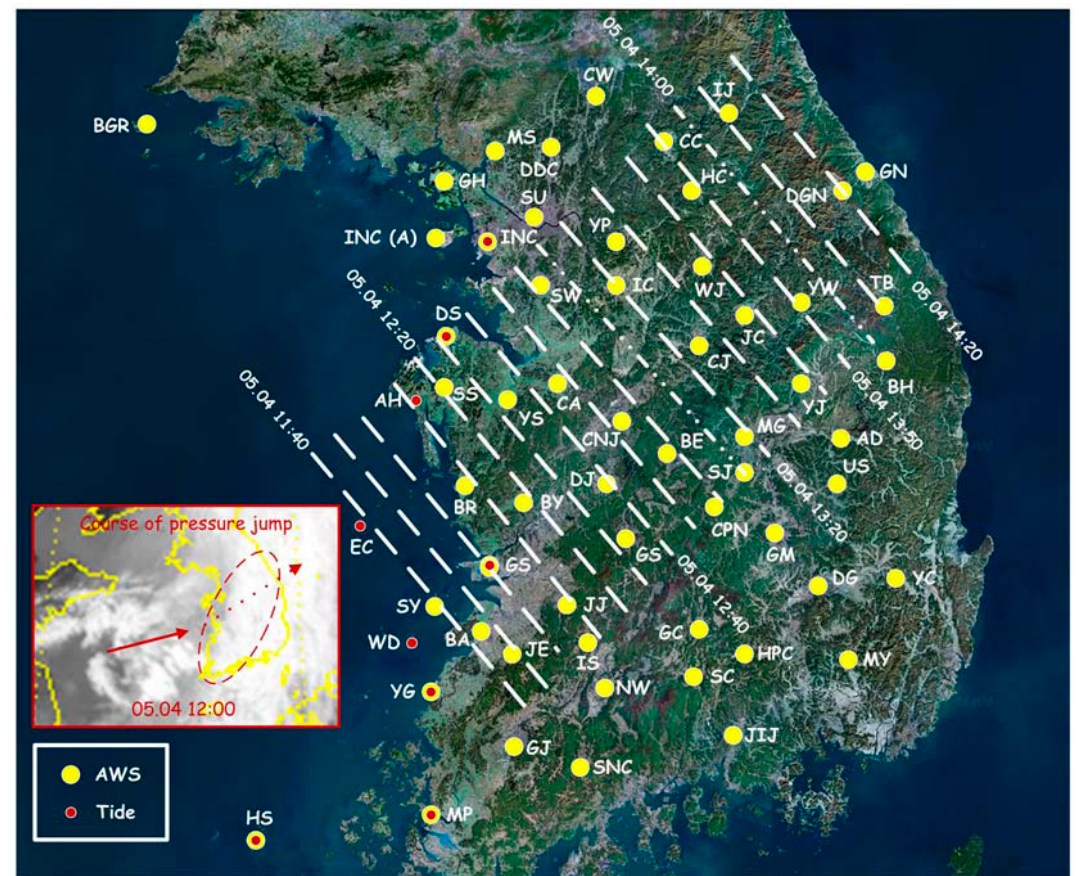
Figure 6. Distribution of pressure jump lines according to arrival time during the meteotsunami that occurred in May 2008 [7].